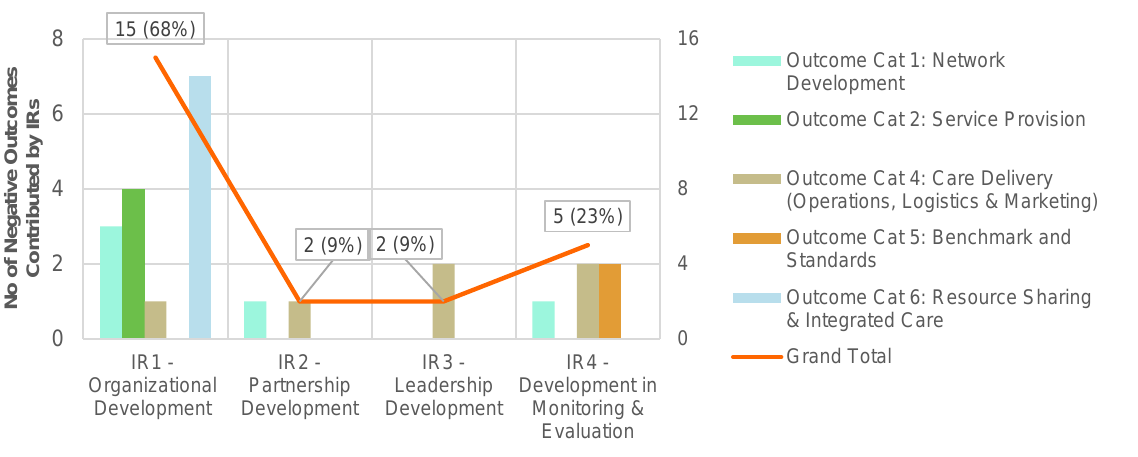
Figure 5. Negative outcomes ( N = 22) a contributed by intermediate results (IRs) b . a Please refer to breakdown of negative outcomes according to categories in Table A3 in Appendix A. b Some outcomes have been contributed by more than one IRs, so the sum of percentages have exceeded 100 percent.